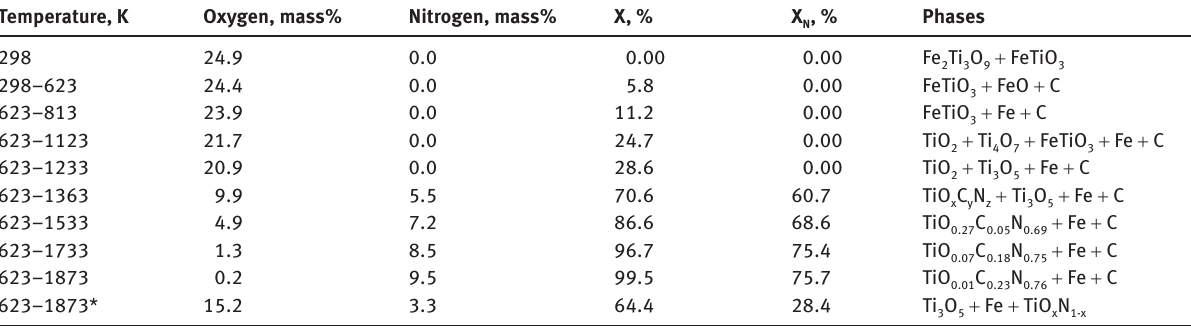
Table 1: LECO analysis and phase composition of primary ilmenite after temperature programmed reduction to different temperatures in the -N gas H 2 2